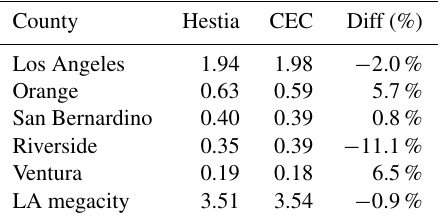
Table 6. Residential natural gas FFCO 2 emissions in the five Hestia-LA domain counties for the year 2011 compared to estimates from the California Energy Commission (CEC). Units: MtCyr − 1